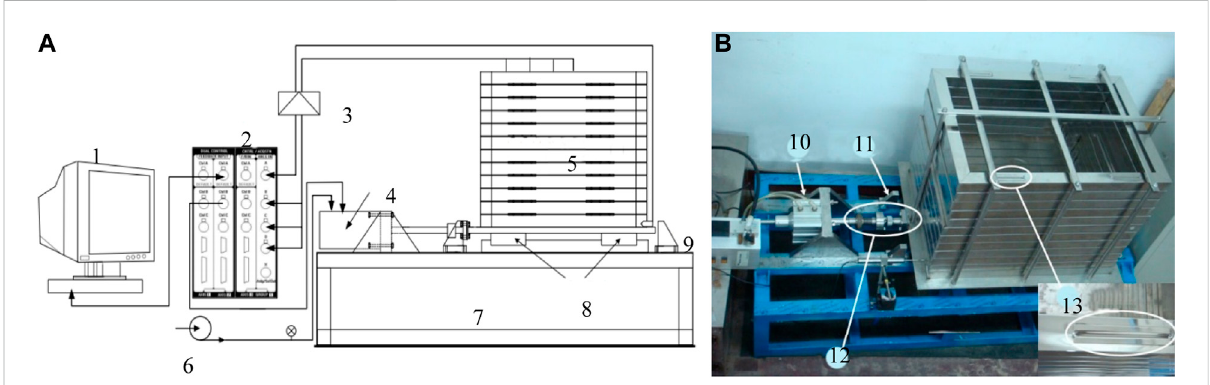
FIGURE 3 Schema of the experimental setup for shaking table and laminar container. (A) Schematic diagram of the shaking table system. (B) The shaking table and laminar shear soil box. 1-control table; 2-CDAS; 3-signal converter, 4-pneumatic power equipment; 5-model box; 6-air pressure supply system; 7-bearing platform; 8-guide rail; 9-limiting device; 10-WFI Pneumatic power equipment; 11-limiting device; 12-connecting device; 13-V shape of